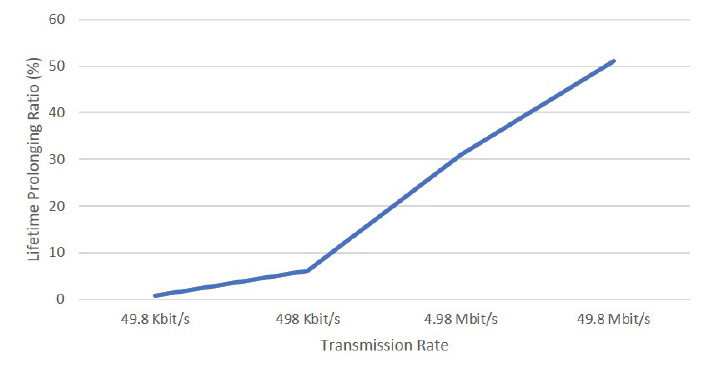
Figure 10. Shows the transmission rate’s impacts on placement